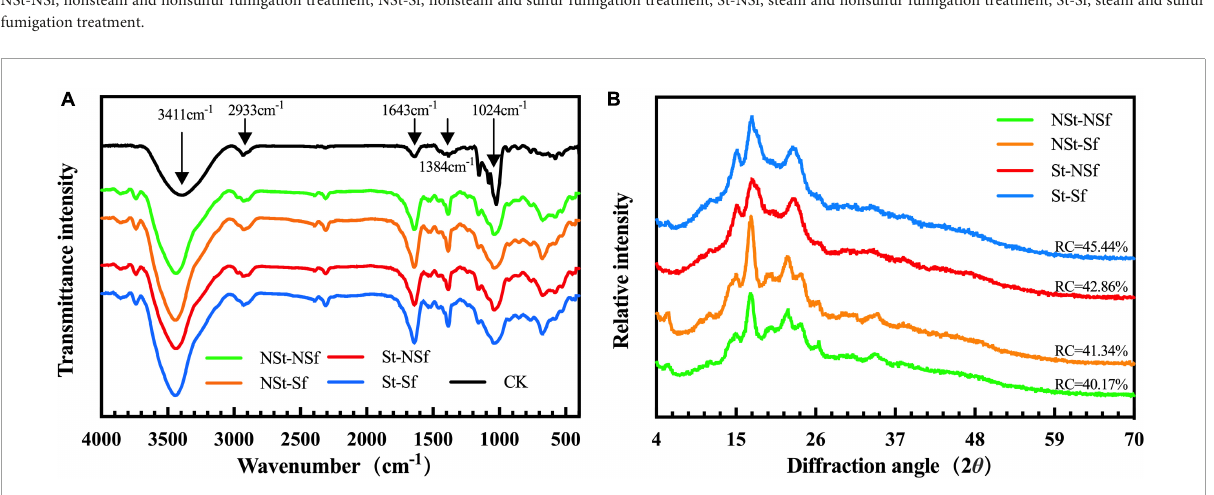
FIGURE5 Fourier transform infrared spectroscopy (FT-IR) (A) and X-ray diffraction (XRD) (B) spectra of Gastrodia elata starch.